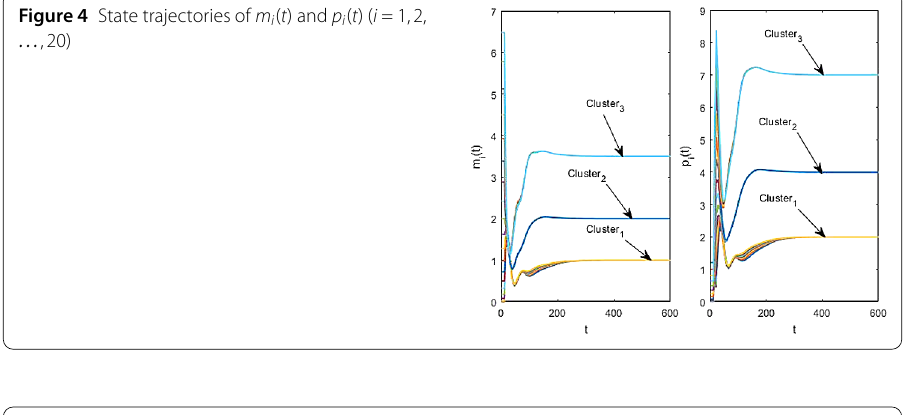
Figure 5 Identification process for adjustment parameter ω ij , ( i = 1, ... ,20; j = 1, ... ,20)